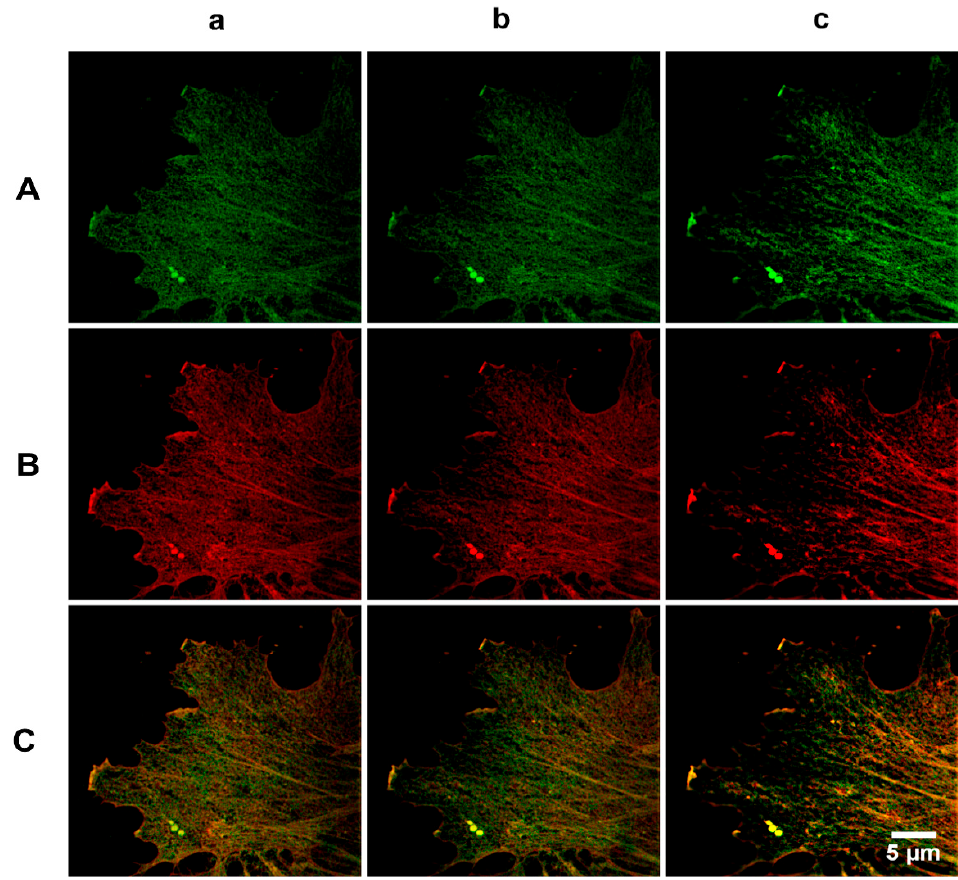
Figure 1. Cytoplasmic β - and γ -actin in human pulmonary artery endothelial cells (HPAEC). Hori- zontal panel ( A ), immunofluorescent staining of β -actin; horizontal panel ( B ), immunofluorescent staining of γ -actin; horizontal panel ( C ), merged. Three consecutive optical sections (three vertical panels) are presented: the section with the most clearly distinguishable structures (panel ( b )) and two adjacent sections, above (panel ( a )) and below (panel ( c )) the selected one.